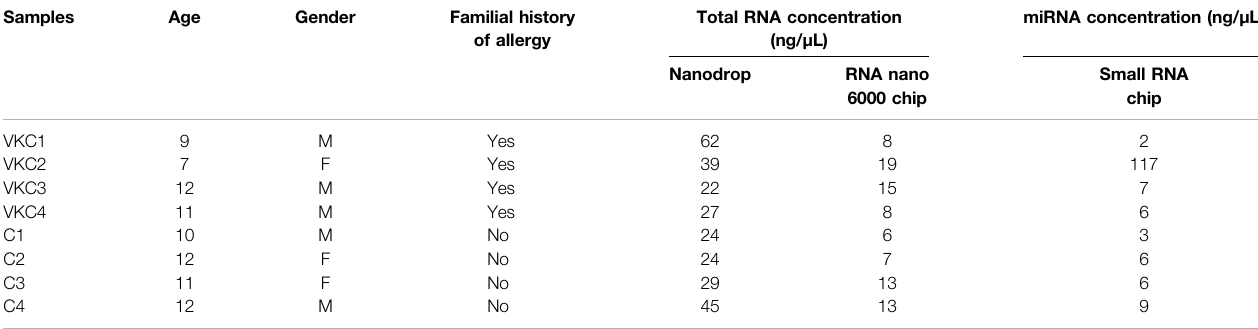
TABLE 1 | Clinical characteristics and concentrations of total RNA and miRNA in tears among children with VKC and control groups.